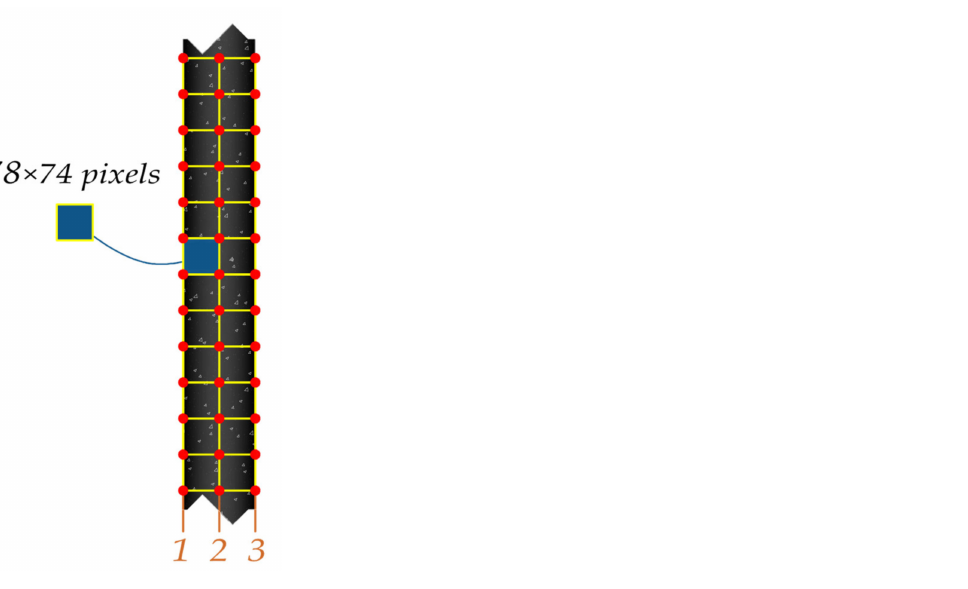
Figure 18. Adopted mesh for DIC analyses: (1) number of pixels within one element and (2) vertical node alignments used to compute the averaged values of